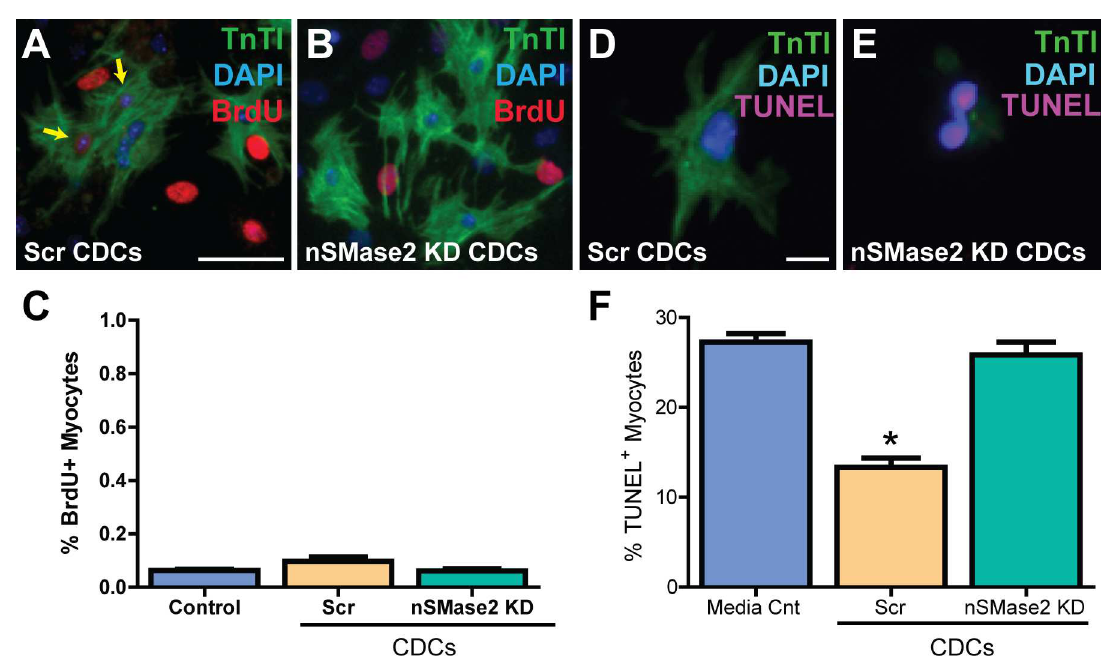
Fig 9. hCDC-derived exosomes significantly decreasecardiomyocyte programed cell death and cause a trend toward increased proliferation of cardiomyocytes in vitro at one week in culture. (A, C) Primary mouse neonatal cardiomyocytes (mCM) (P1-3) cocultured with Scr CDCs exhibiteda trend toward a higher percentageof BrdU+ cells at one week followinga 5 day pulse when compared with (B, C) mCM cocultured with nSMase2 KD CDCs (n = 4; p = 0.19 using one- way ANOVA with Tukey’s post hoc test). Scale bar 50 μ m. (D, F) mCM coculturedwith Scr CDCs exhibitedfewer terminal deoxynucleotidyl transferase nick end labeling(TUNEL)-positive nuclei at one week when comparedwith (E, F) mCM cocultured with nSMase2 KD CDCs and media control (n = 4). The magnitudeof the effect of CDC exosomes on myocyte apoptosiswas nearly two orders of magnitudelarger than proliferation assessed by BrdU over this time frame. Scale bar 10 μ m. * p < 0.001 using one-way AVOVA (Tukey’s post hoc test). Data are presented as mean ±